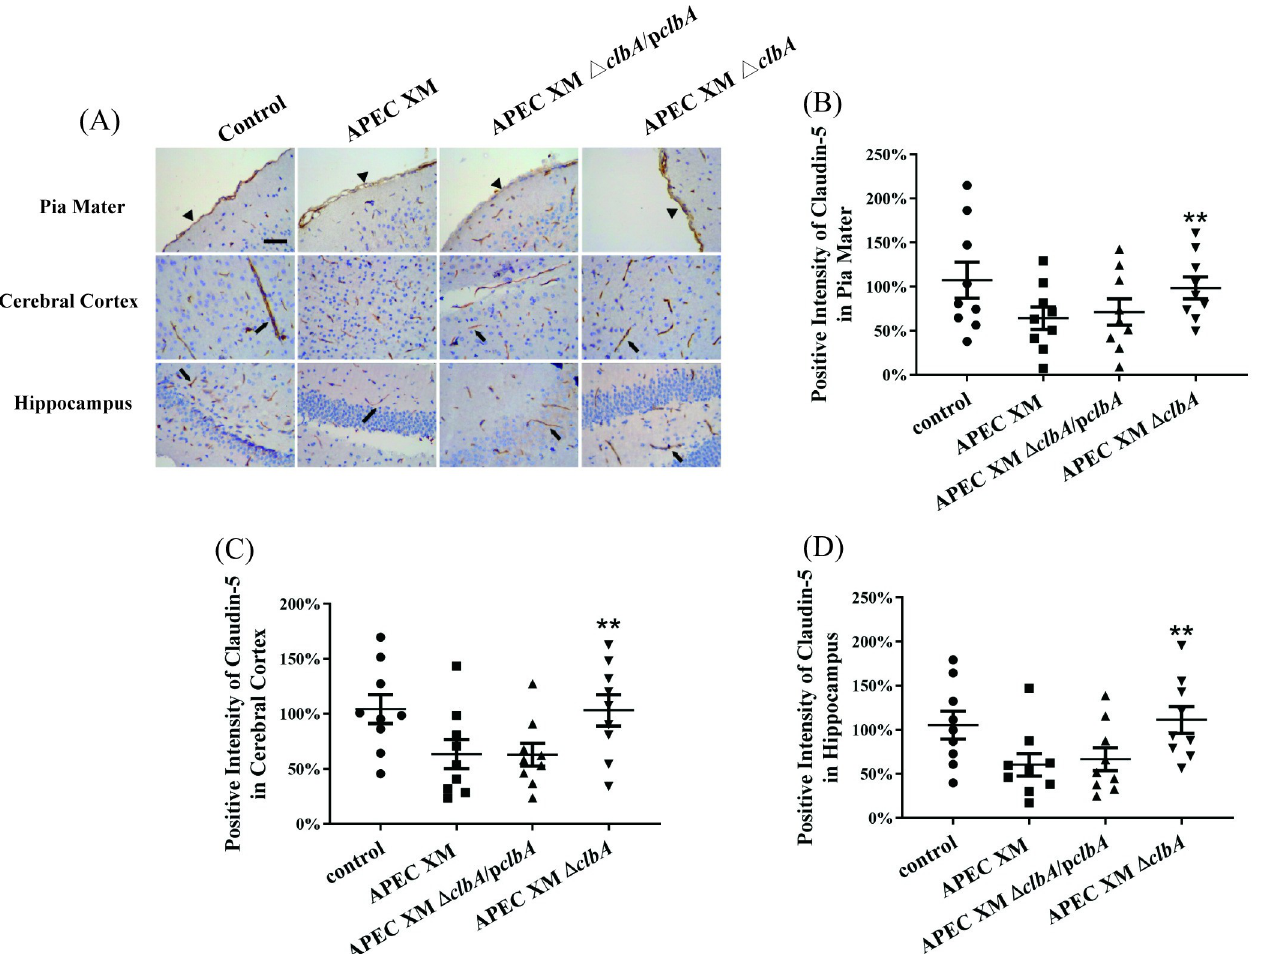
Fig 5. The expressions of claudin-5 in the brain were measured by immunohistochemistry. (A) Immunohistochemistry staining of claudin-5 protein in infected mouse brains (bar = 20 μ m). (B-D) The percentage of positive staining intensity of claudin-5 in pia mater (B), cerebral cortex (C) and hippocampus (D). The methods of positive staining intensity calculation and data analysis were same as that in Fig 4.